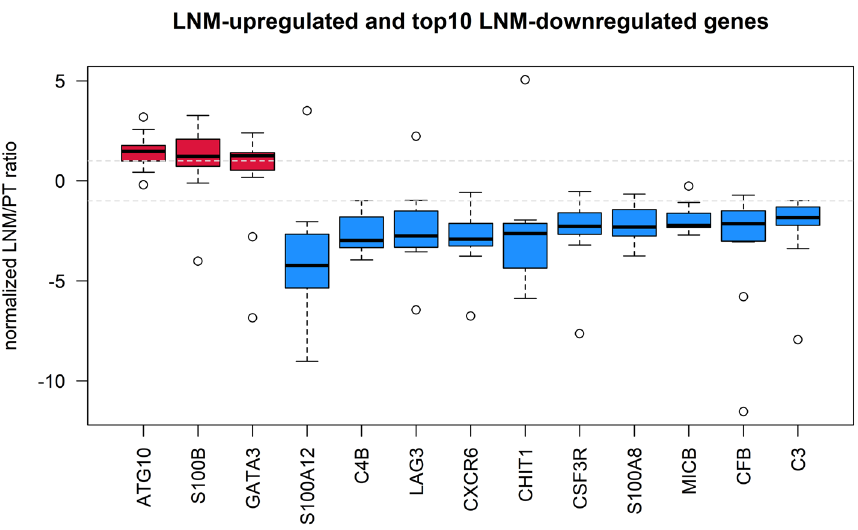
Figure 2. Distribution of normalized LNM/PT ratios of LNM-upregulated and -downregulated genes. Genes were classified as LNM-upregulated (red) and LNM-downregulated (blue; top10 out of 33 genes are depicted) based on the median normalized LNM/PT ratio and opposite LYMPHNODE/BREAST and median matched LNM/PT ratios. Grey dashed lines represent the cut-off for LNM-enrichment (1) and LNM-depletion